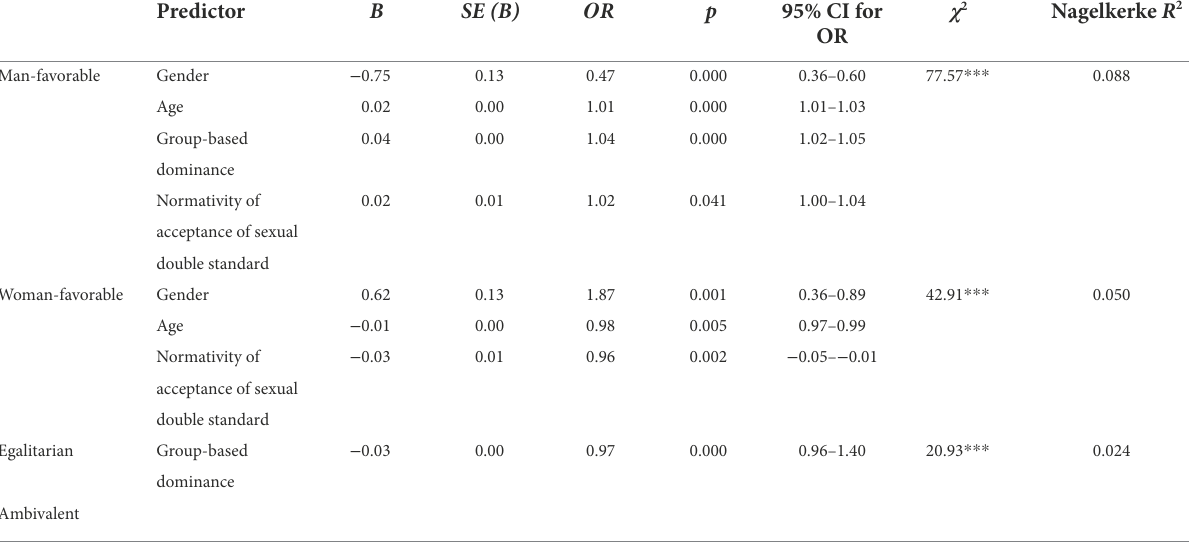
TABLE 6 Hierarchical logistic regressions of predictors of the SDS adherence typologies referring to the sexual freedom domain. Predictor